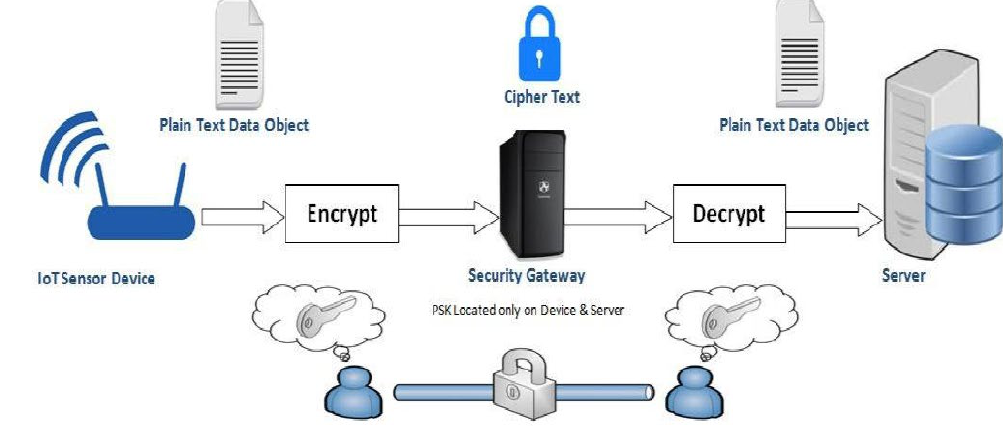
Figure 2. Encryption of Data Objects Zhang et. al. [9]